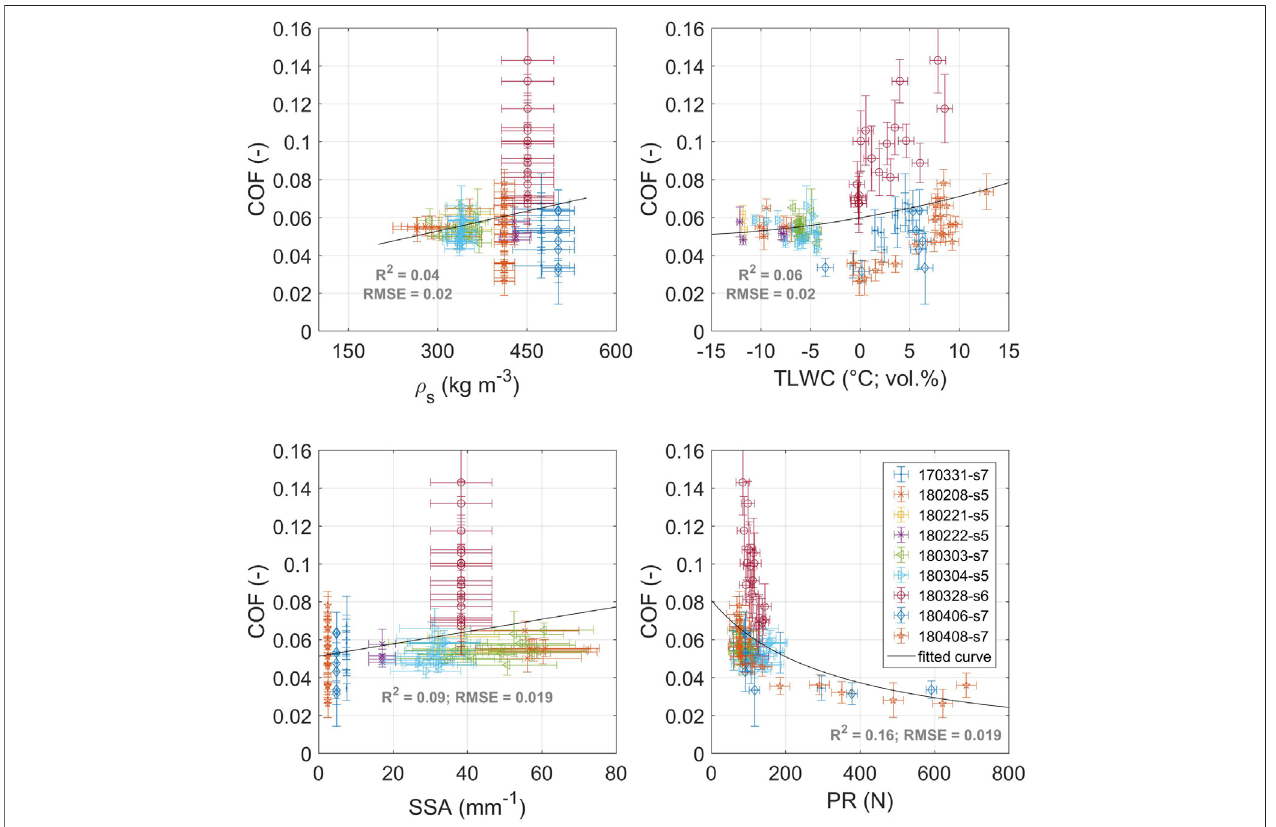
FIGURE7| Mean( ± σ )frictioncoef fi cientsofallanalyzed( n (cid:1) 100)snowboardrunsplottedversusthecorrespondingapproximatedsnowproperties( ± RMSE)atthe time of each run. Fitted curves represent single snow parameter models speci fi ed in the